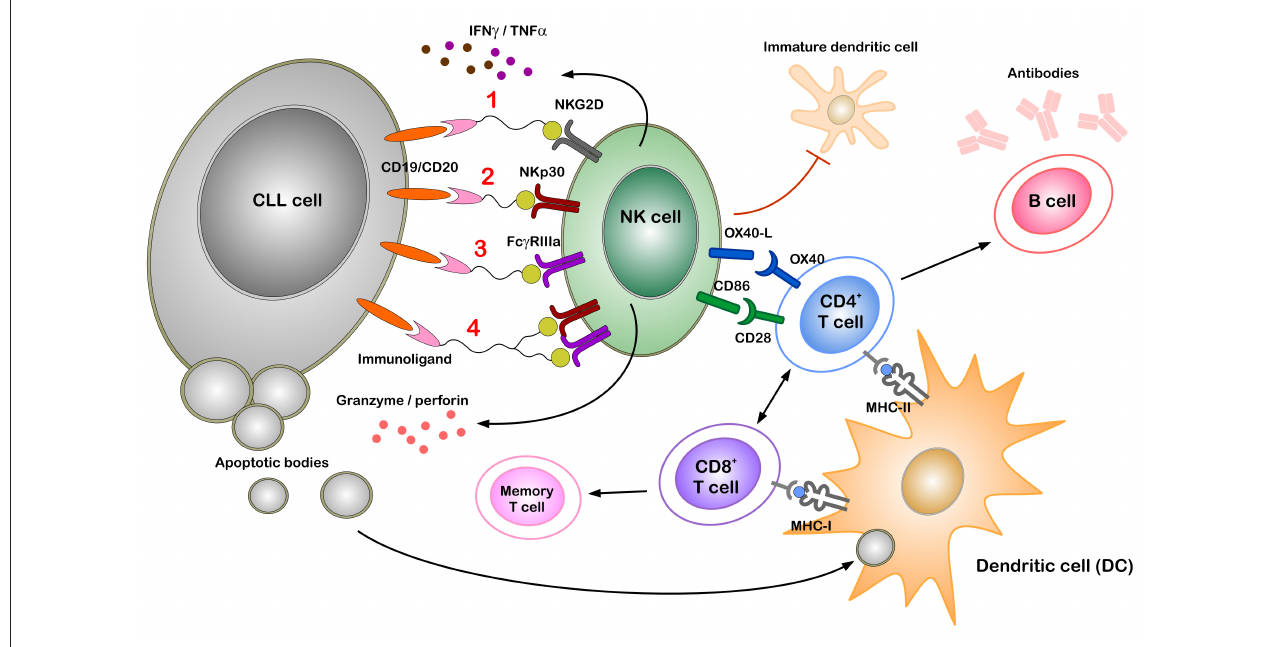
FIGURE 2 | Potential role of immunoligands to redirect NK cells to CLL cells. Immunoligands with specificities for CLL cells (through CD19 or CD20) and for NK cells [through activating receptors on NK cells such as NKG2D, NKp30, Fc γ RIIIa or simultaneous NKp30 and Fc γ RIIIa(1–4)] can link and activate respective immune cells even in the presence of active immune suppression. Stimulating of either of the activating receptors on NK cell leads to cytokine secretion (IFN γ , TNF α ) and degranulation, thereby killing tumor cells by apoptosis. Professional antigen presenting cells (APCs) such as dendritic cells (DCs) phagocytose components of dying tumor